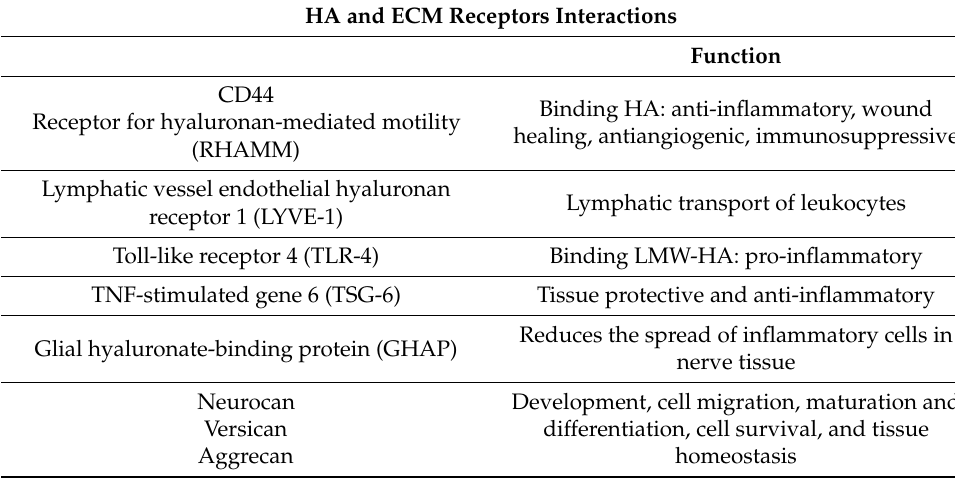
Table 3. HA interactions. RHAMM, receptor for hyaluronan-mediated motility; LYVE-1, lymphatic vessel endothelial hyaluronan receptor 1; TLR-4, Toll-like receptors 4; TSG6, TNF-stimulated gene